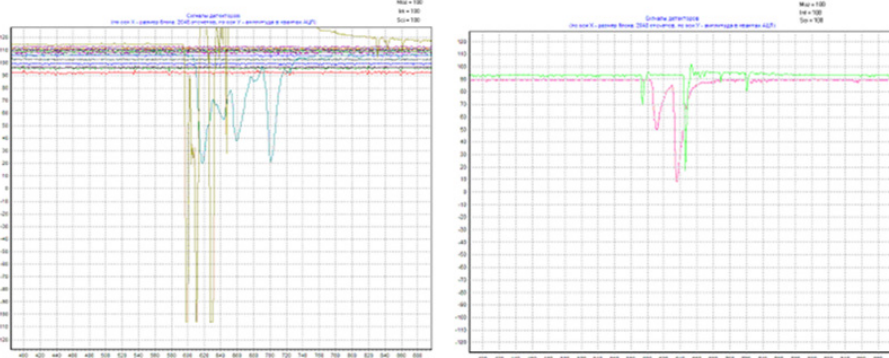
Figure 5. Distribution of pulses from electron and muon asymmetry in the air shower disc. Air shower event from 22.03.2009, θ = 32 . 4 ◦ , lgE 0 = 19 . 45. a) R = 549m b) R = 886m. Fig. 3a, double lines indicate the boundaries at 1 σ